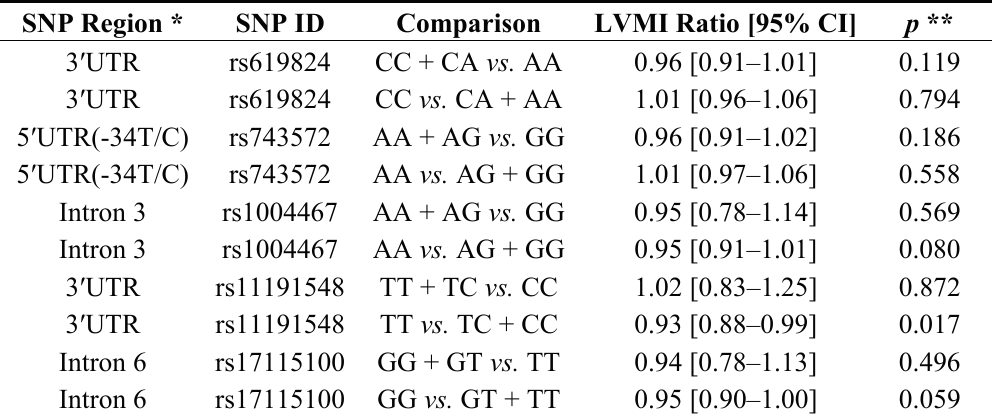
Table 3. Relation of single nucleotide polymorphisms (SNPs) with left ventricular mass index (LVMI) in stepwise multivariate adjusted analysis according to combined